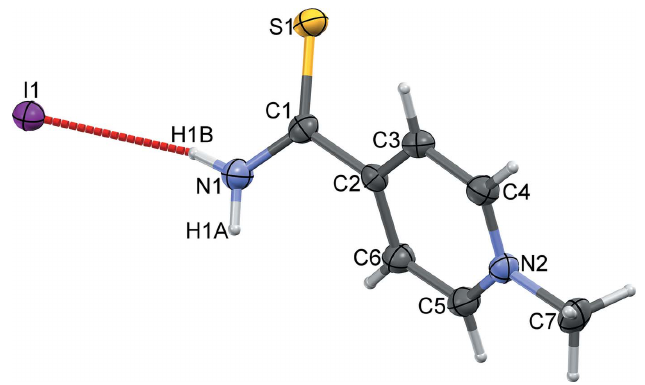
Figure 1 The molecular structure of the ion pair with the labelling scheme and 50% displacement